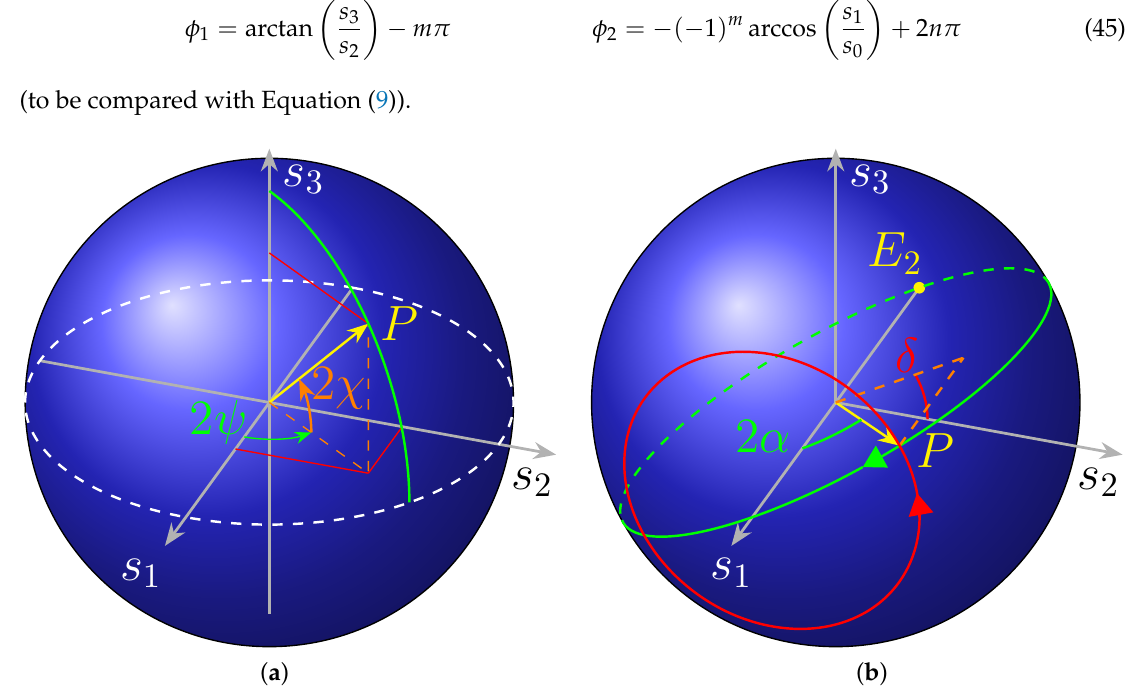
Figure 12. Poincaré sphere. ( a ) Any SOP can be represented by a point P on its surface, by Equation (42). The usual spherical coordinates are used. ( b ) Poincaré sphere with the angles as in Equation (41). The point P corresponds to a generic polarisation state. The red and green circles display the trajectory on the sphere when a complete sweep is performed on the angle δ ( φ 1 ) and α ( φ 2 ), respectively, while the other is held constant. Notice the direction of the arrows on the circles: scanning on δ results in a counterclockwise rotation, whereas the opposite happens for α , as the phase shifter is assumed to be in the lower